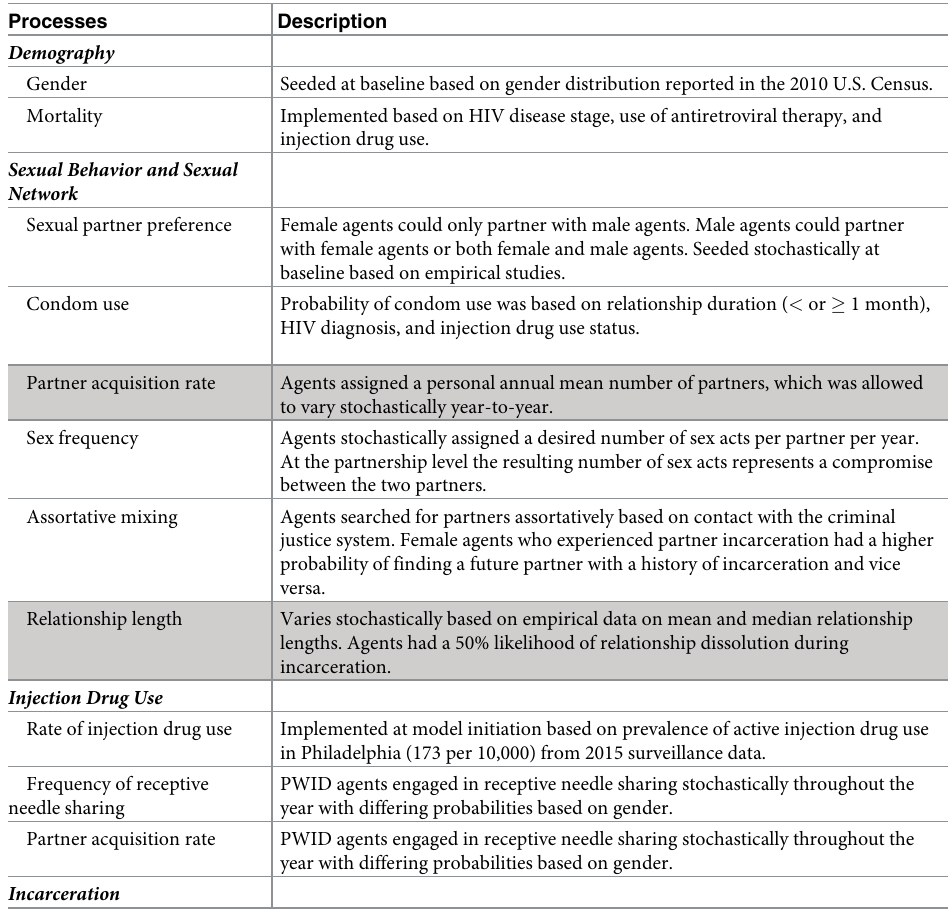
Table 1. Overview of parameters and processes for a model of heterosexual HIV transmission among African American men and women in Philadelphia, PA.